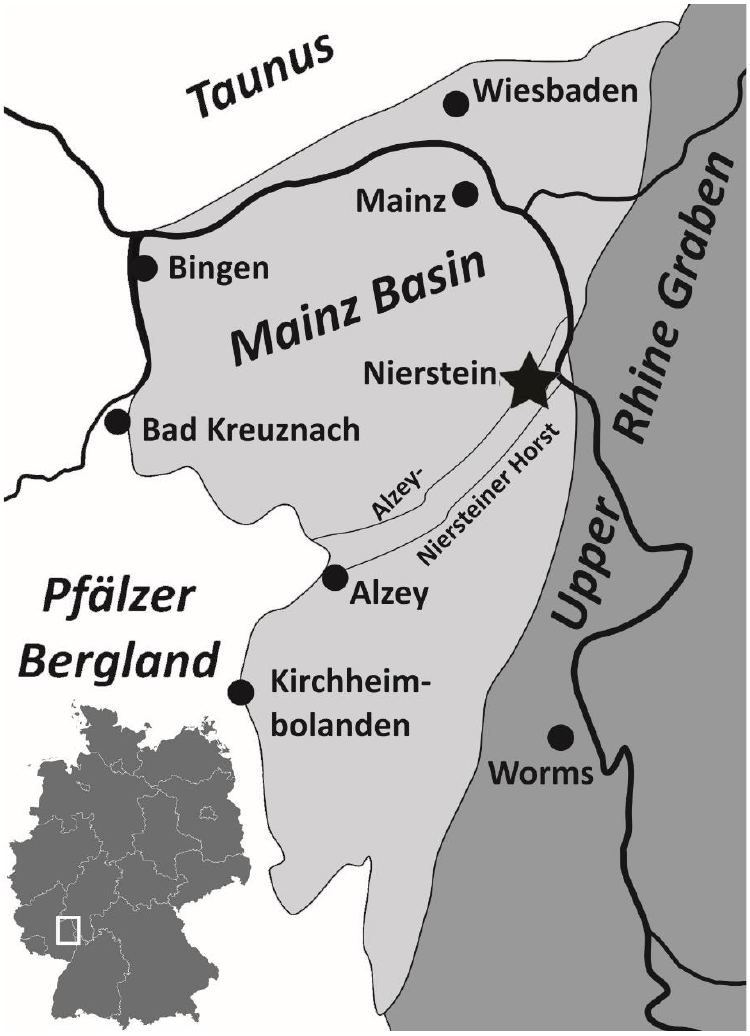
Figure 1. Tectonic limits of the Mainz Basin, with sampling locality highlighted by a star, modified from Schäfer [13].